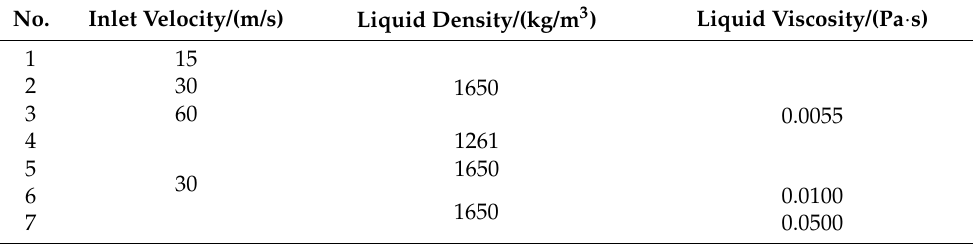
Figure 2. Schematic diagram of the geometric model (mm). Table 2. The setting of simulation parameters.